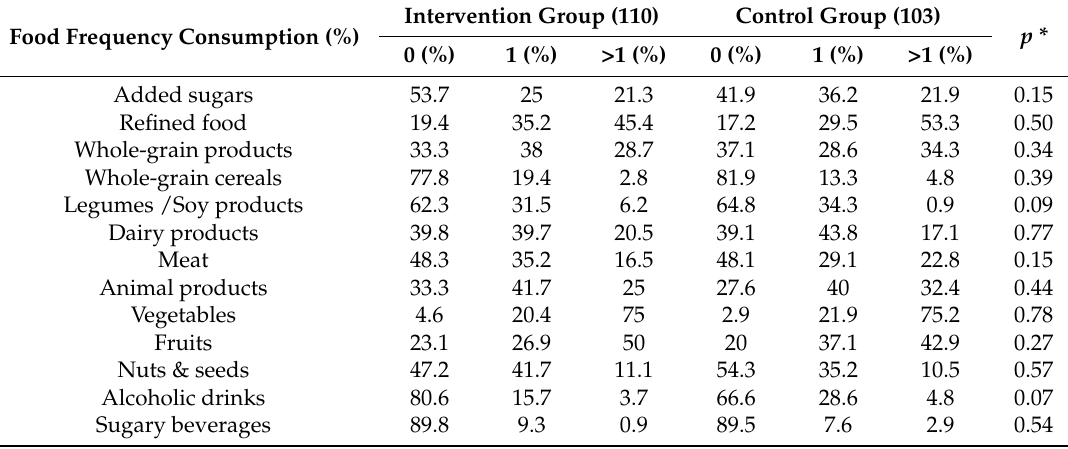
Table 2. Baseline frequency of consumption of selected food or food groups (213 women).